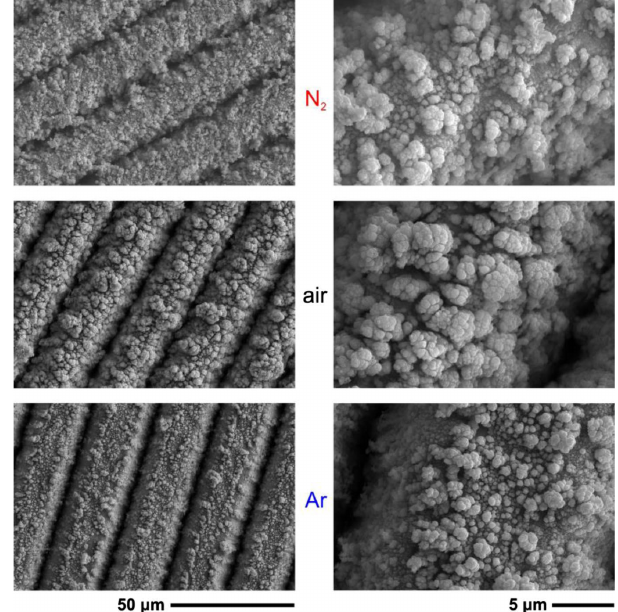
FIG. 9. SEY measurements of a LH-patterned sample treated in argon atmosphere: at room temperature (black line), at ≈ 10 K (green line), and after exposure to an electron dose of 6 . 1 × 10 − 6 (red line) and 1 . 8 × 10 − 5 C mm − 2 (blue line).